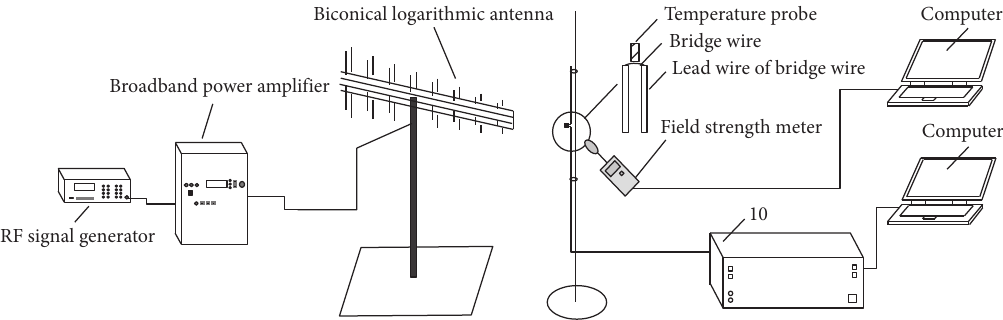
Figure 7: Schematic diagram of the bridge wire temperature rise test of EED under strong electromagnetic field. Table 4: Test results of the bridge wire temperature increase under strong electromagnetic field at ambient temperature of 32.2 ° C. Electric intensity (V/m)